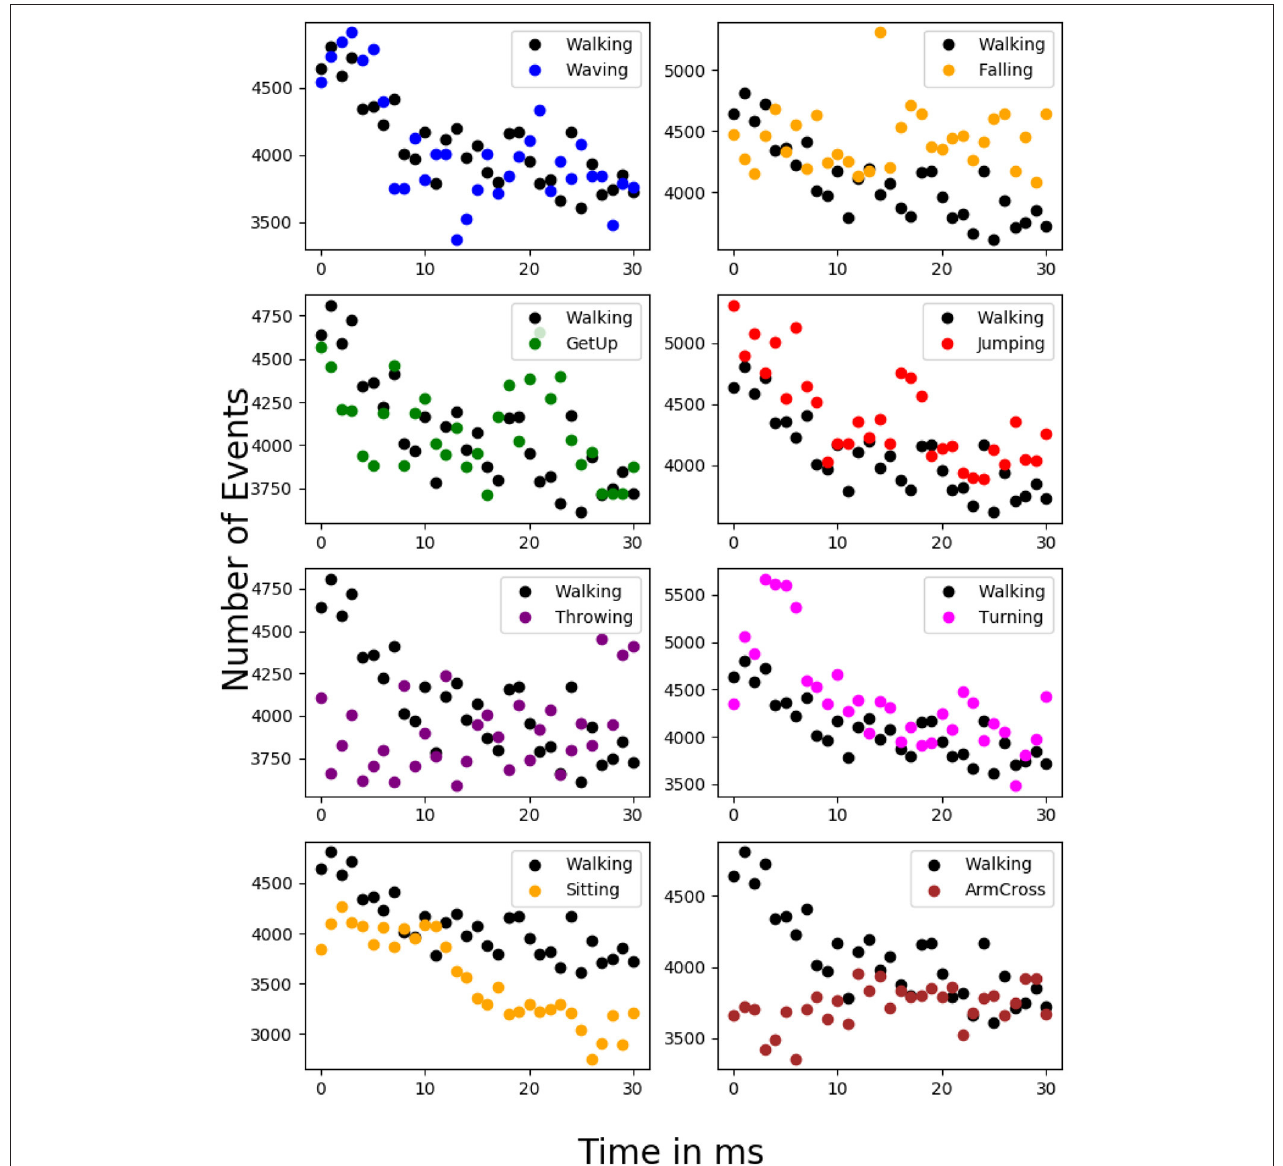
FIGURE 4 | Display of event rate of normal vs. anomalous activity at different time instants for a standard time interval of 50 ms. Huge overlap in the event rate indicates that the anomalous activities considered do not differ from normal activity in terms of rate of